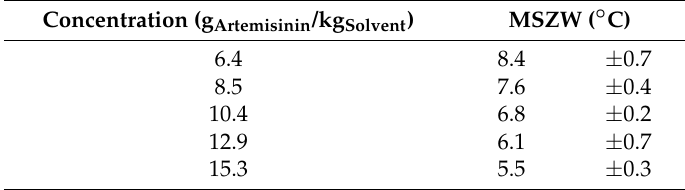
Table 2. Metastable zone width of artemisinin in 60 wt.% ethanol (MSZW: metastable zone width).